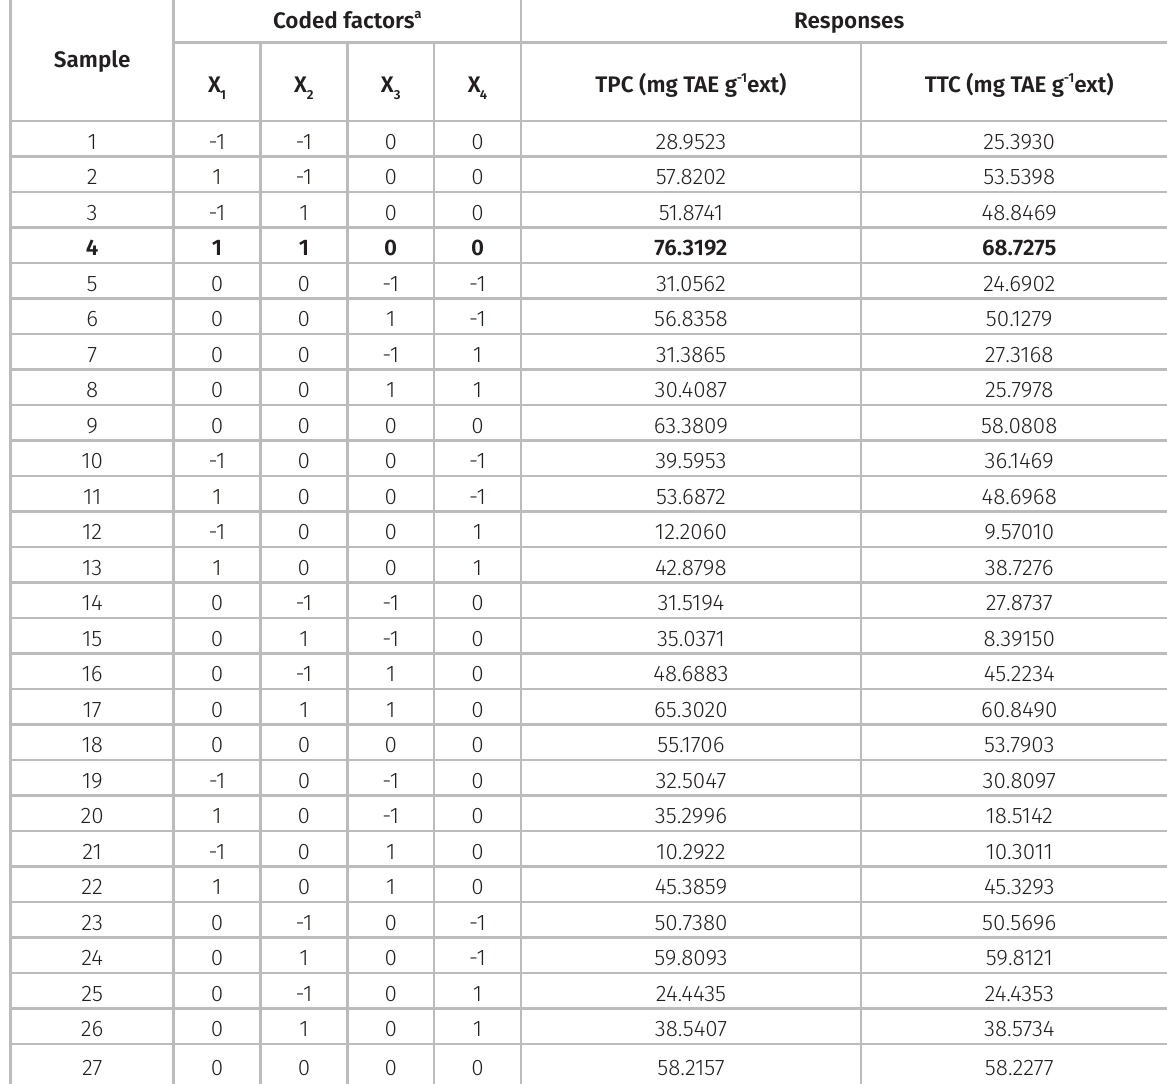
Table II. Responses obtained from the Box-Behnken experimental design for optimizing TPC and TTC (mg TAE g -1 ext) in the extract from S. cumini leaves through microwave-assisted extraction . The bold line represents the best